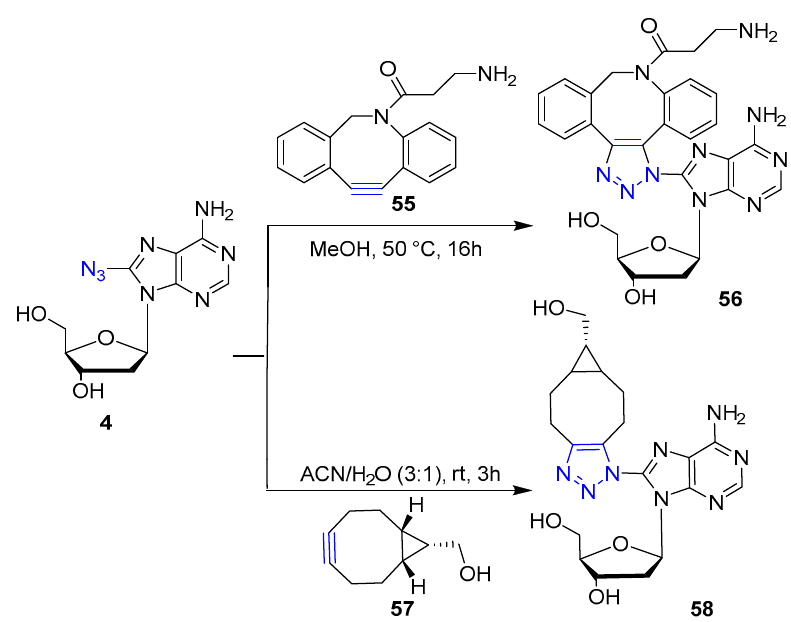
preparation of fluorescent nucleosides for living cells imaging. Zayas et al. reported